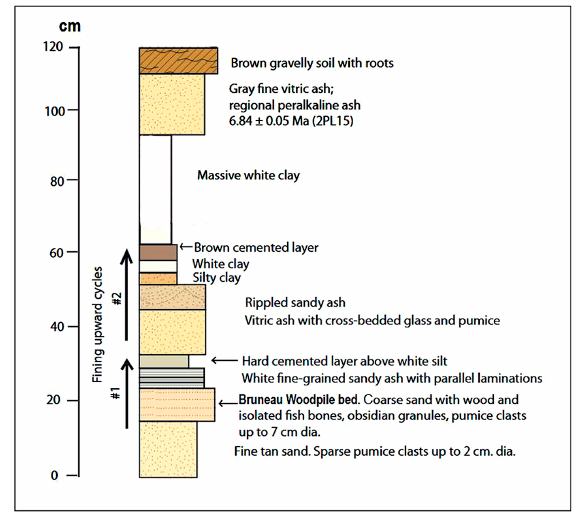
Figure 4. Generalized stratigraphic section of the Chalk Hills Formation beds at Bruneau Woodpile Figure locality.